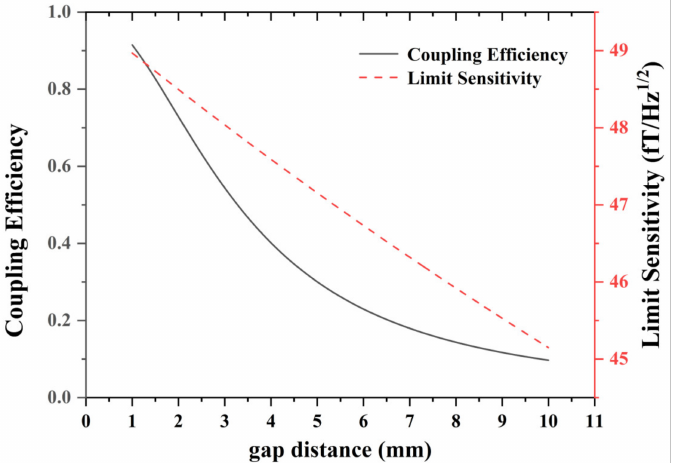
Figure 4. The limit sensitivity and the coupling efficiency with the gap